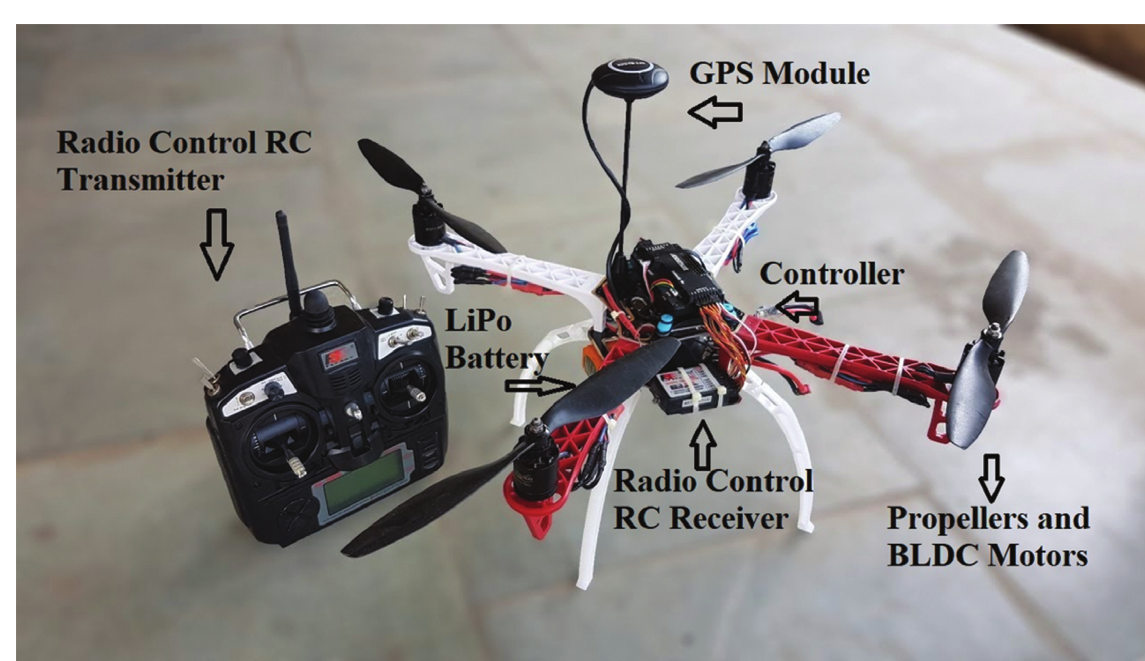
Figure 11: Assembled quadcopter